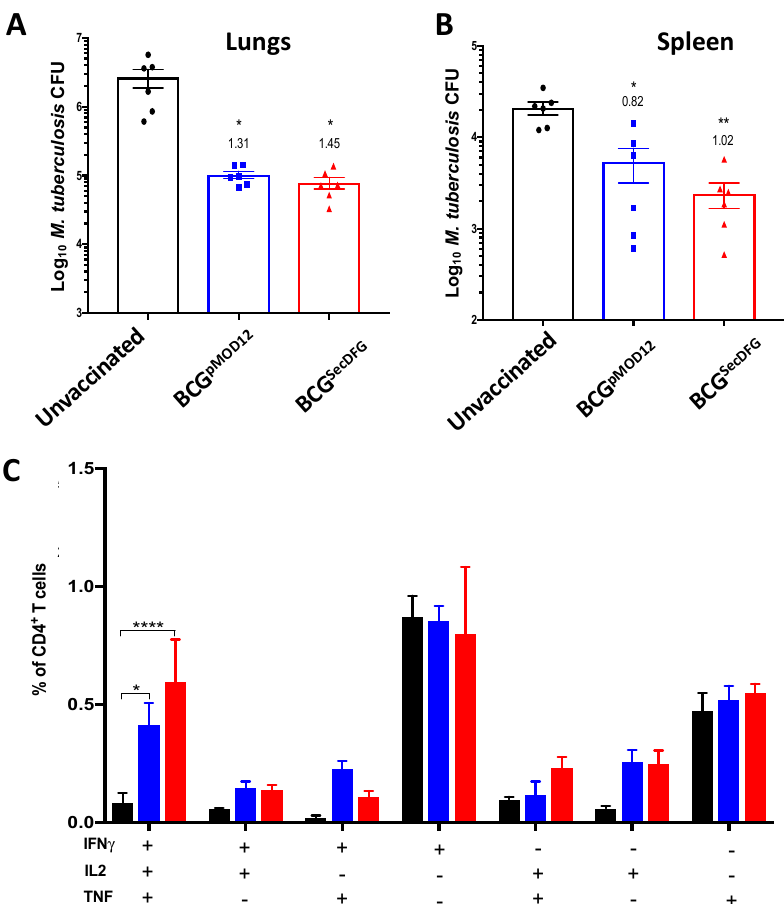
Figure 4. Protection afforded by BCG SecDFG vaccination against aerosol M. tuberculosis infection in C57BL/6 mice. C57BL/6 mice ( n = 6) were immunized s.c. with 5 × 10 5 CFU of BCG pMOD12 (blue) or BCG SecDFG (red), or PBS as control (black), and 10 weeks post-immunization, mice were challenged with ~100 CFU of M. tuberculosis H37Rv via aerosol route. The bacterial loads in lungs ( A ) and spleens ( B ) were enumerated following culture on Middlebrook 7H11 agar. ( C ). Intracellular cytokine staining was performed on lung cells at 4 weeks post-infection after re-stimulation with CFP (10 µ g/mL) and Brefeldin A, and the frequency of IFN- γ , IL-2, and/or TNF-positive CD4 + T cells was assessed by flow cytometry. The data are the means ± SEM and representative of two independent experiments. The numbers on top of the bar graphs indicate the Log protection compared to the unvaccinated group. Statistical significance was determined by ANOVA with Tukey’s multiple-comparisons test (* p < 0.05; ** p < 0.01; **** p < 0.0001).